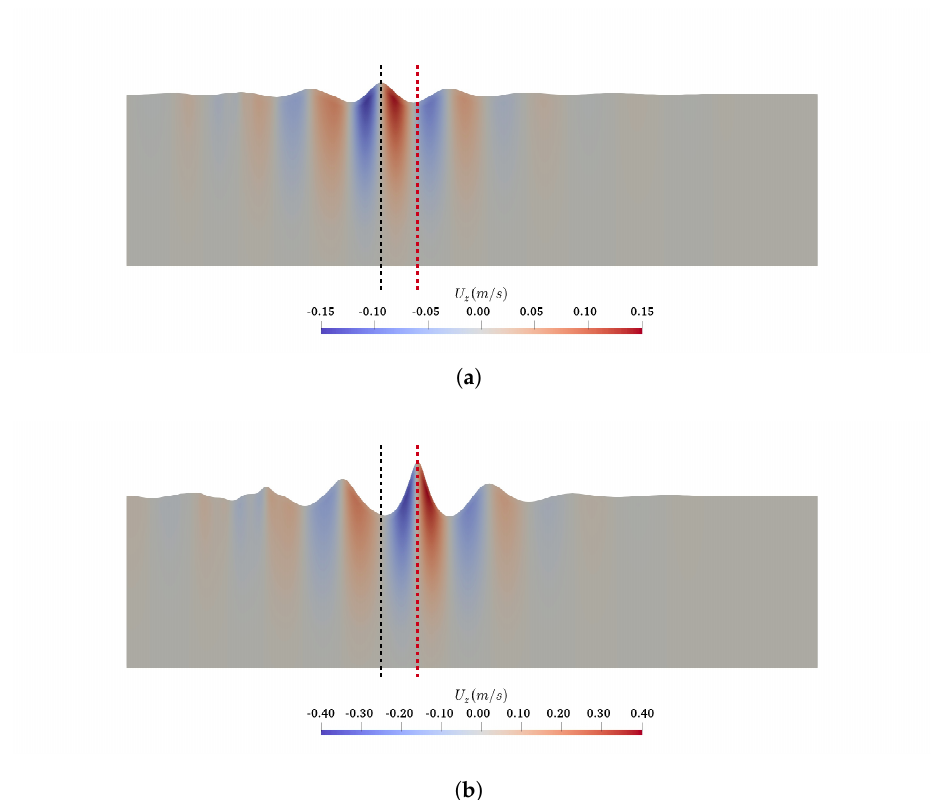
Figure 14. The vertical velocity in the wave fields at the focusing time, ( a ) for the simulation case NING1 with a less steep input wave, ( b ) for the simulation case NING3 with a more steep input wave. The black vertical dashed line in ( a ) indicates the location of the focused wave crest in the case NING1, and the red vertical dashed line in ( b ) indicates the location of the focused wave crest in the case NING3. The black dashed line in ( a ) is extended to ( b ), and the red dashed line in ( b ) is extended to ( a ) so that the horizontal distance between the focused wave crests in the two cases is straightforwardly